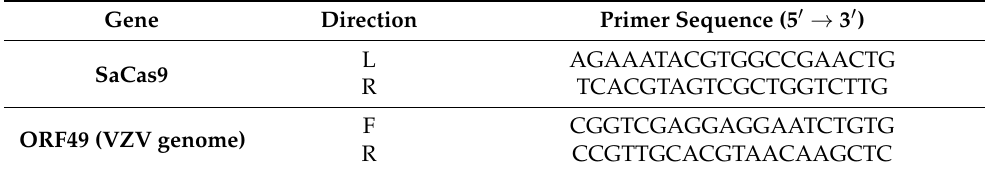
Table 2. Primers for Quantification of